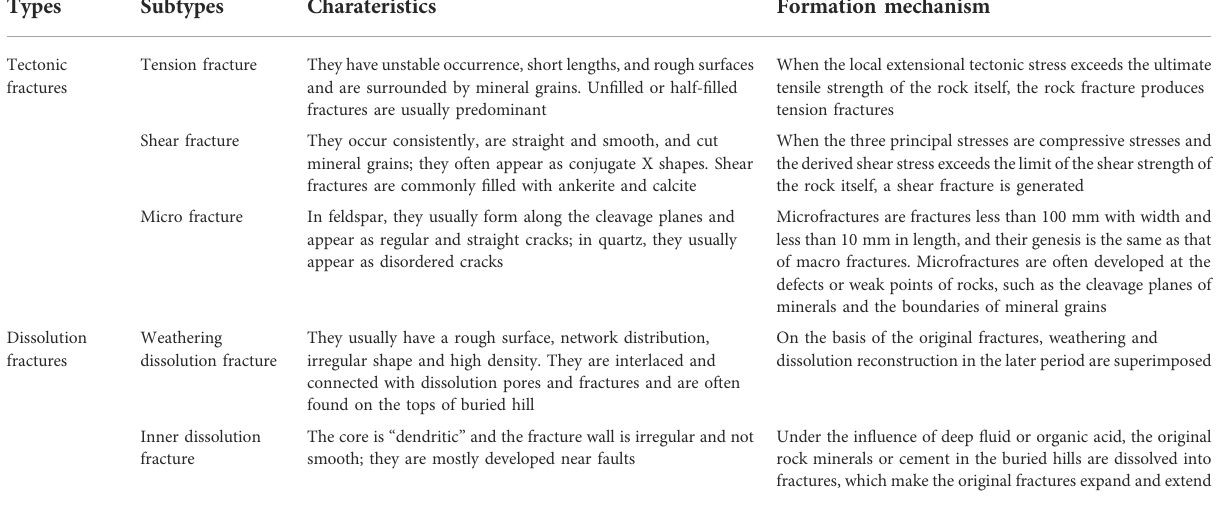
TABLE 2 Main fracture types of Archaean metamorphic rocks in the study